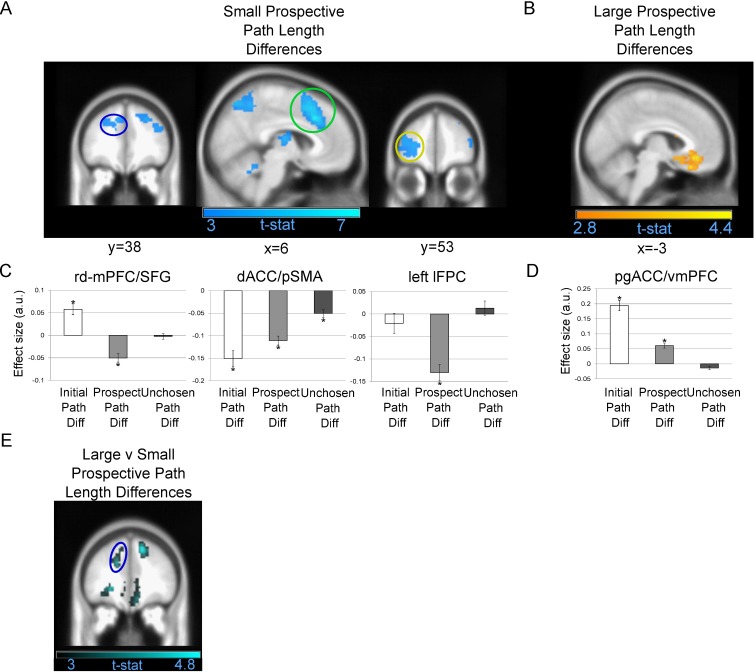
Prefrontal responses to prospective path length differences.(A) Regions significantly responding to smaller prospective path length differences. Left: Coronal image showing rd-mPFC/superior frontal gyrus (SFG). Centre: Sagittal image showing dACC/pSMA. Right: Coronal image showing left lFPC. (B) Pregenual anterior cingulate cortex/ventromedial PFC (pgACC/vmPFC) region significantly engaged by larger prospective path length differences. (C) Effect size for an 8-mm sphere around the rd-mPFC/SFG (left), dACC/pSMA (centre), and left lFPC (right) peak voxels that responded to smaller prospective path length differences displayed in A for three parametric modulators: initial (including both deep and shallow mazes), prospective, and unchosen path length differences (mean ± standard error of the mean [SEM]). (D) Effect size for an 8-mm sphere around the pgACC/vmPFC peak voxel that responded to larger prospective path length differences. For both C and D, asterisks indicate a significant correlation (p < 0.05) with path length differences. A positive effect size represents a BOLD correlation with larger path length differences, whereas a negative effect size represents a correlation with smaller path length differences. (E) Images centred on rd-mFPC peak in A, which was the only region featured in a that significantly responded to decreasing prospective versus initial choice path length differences in shallow mazes. All highlighted regions survived cluster-level FWE correction at p < 0.05 and are displayed at an uncorrected statistical threshold of p < 0.005. Corresponding coordinate from the Montreal Neurological Institute (MNI) template image listed below each brain image. See S2 Data for individual effect size data.